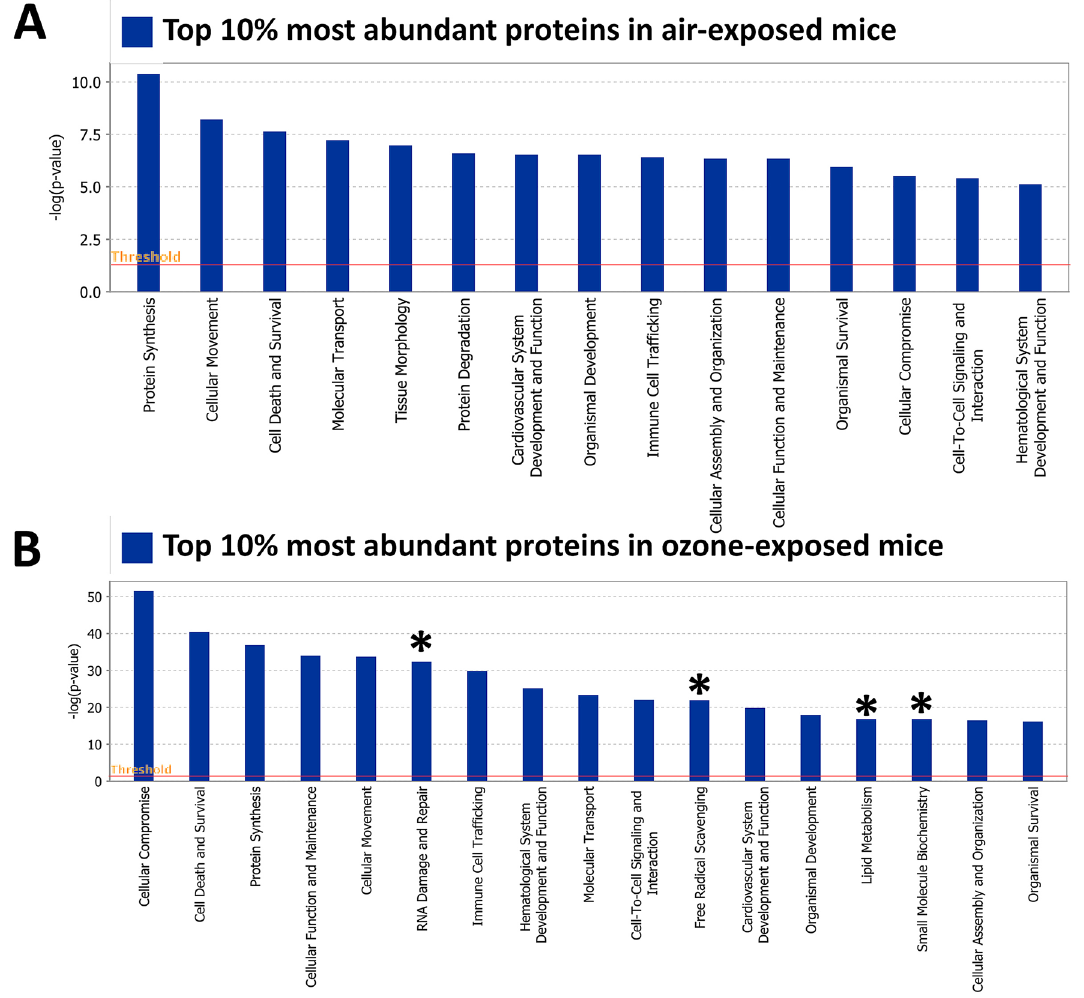
Figure 6. Biological pathway analyses on abundant proteins in BALF exosomes from air- and ozone-exposed mice. ( A ) Ingenuity pathway analysis (IPA) on most abundant (top 10%; 326 out of 3258 identified proteins, determined by Log2 VSN normalized iBAQ MS1 intensities) proteins in exosomes harvested from air-exposed mice. Pathways related to “molecular and cellular functions” and “Physiological system development and function” categories were interrogated for their enrichment. ( B ) Ingenuity pathway analysis (IPA) on most abundant (top 10%; 342 out of 3421 identified proteins, determined by Log2 VSN normalized iBAQ MS1 intensities) proteins in exosomes harvested from ozone-exposed mice. The asterisk represents pathways that were uniquely enriched in exosomes harvested from ozone-exposed